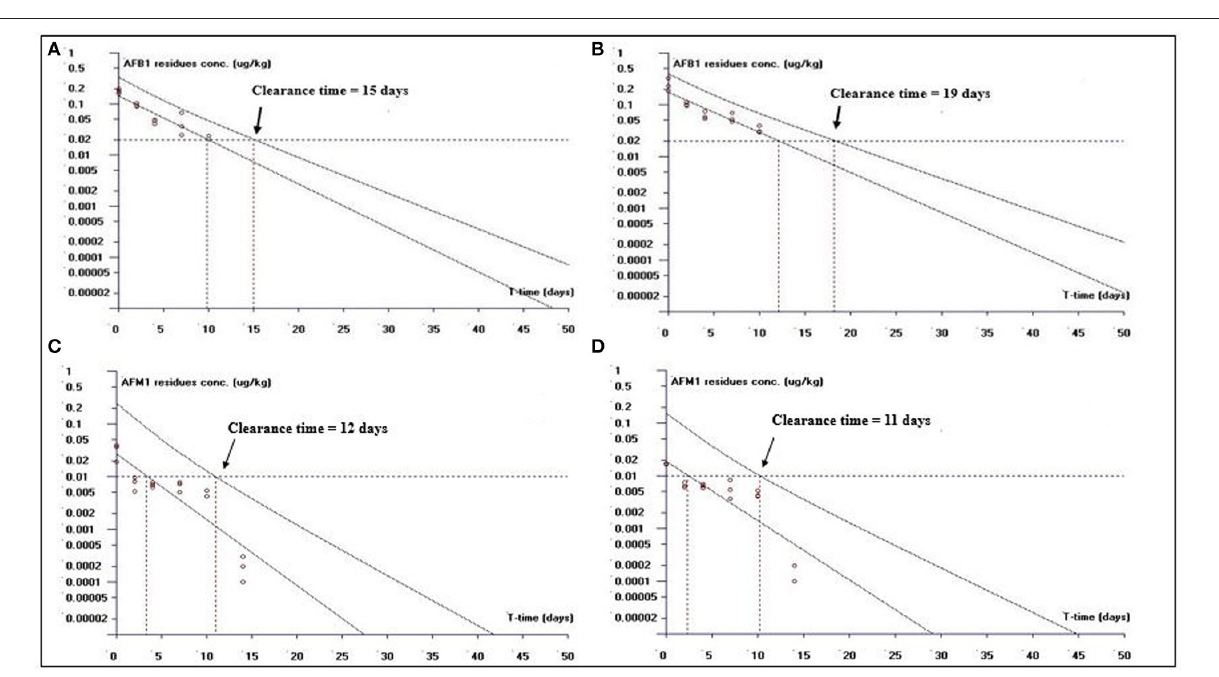
Frontiers in Pharmacology | www.frontiersin.org